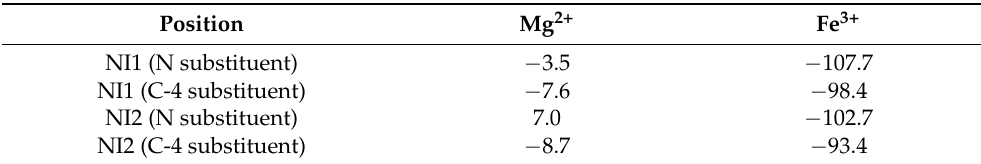
Table 7. Gibbs energies ∆ G 37 for the formation of metal complexes (reactions NI + M 2+ / 3+ → NI@M 2+ / 3+ ) in DMF, in kcal mol − 1